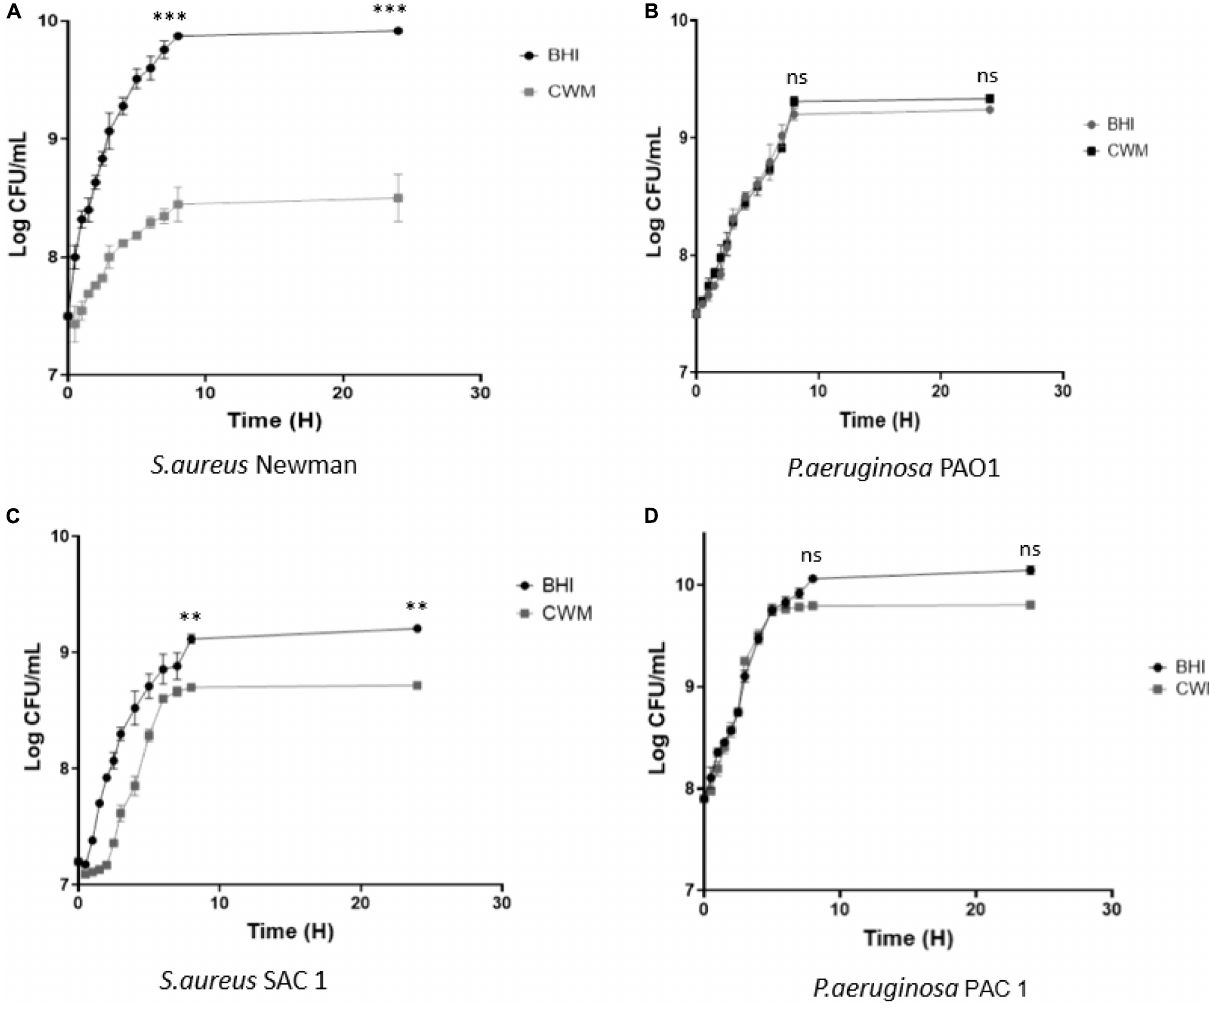
(BFI = 3.7 ± 0.2 vs. 19 ± 0.1 and 2 ± 0.2 vs. 6.7 ± 0.3,